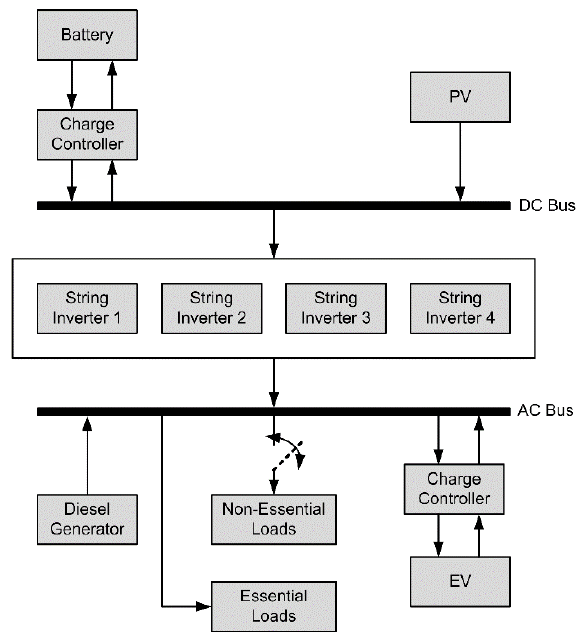
Figure 9. Block diagram of the simulation framework.